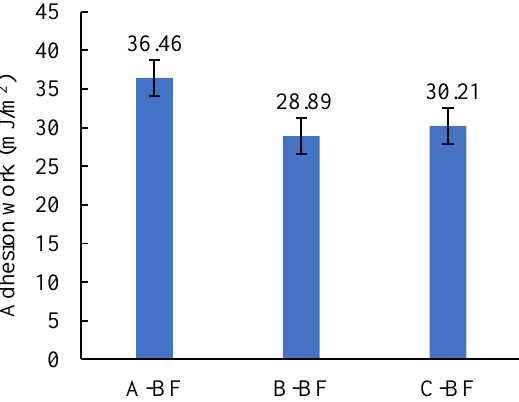
Figure 9. The adhesion work between BF and the asphalt mastic.